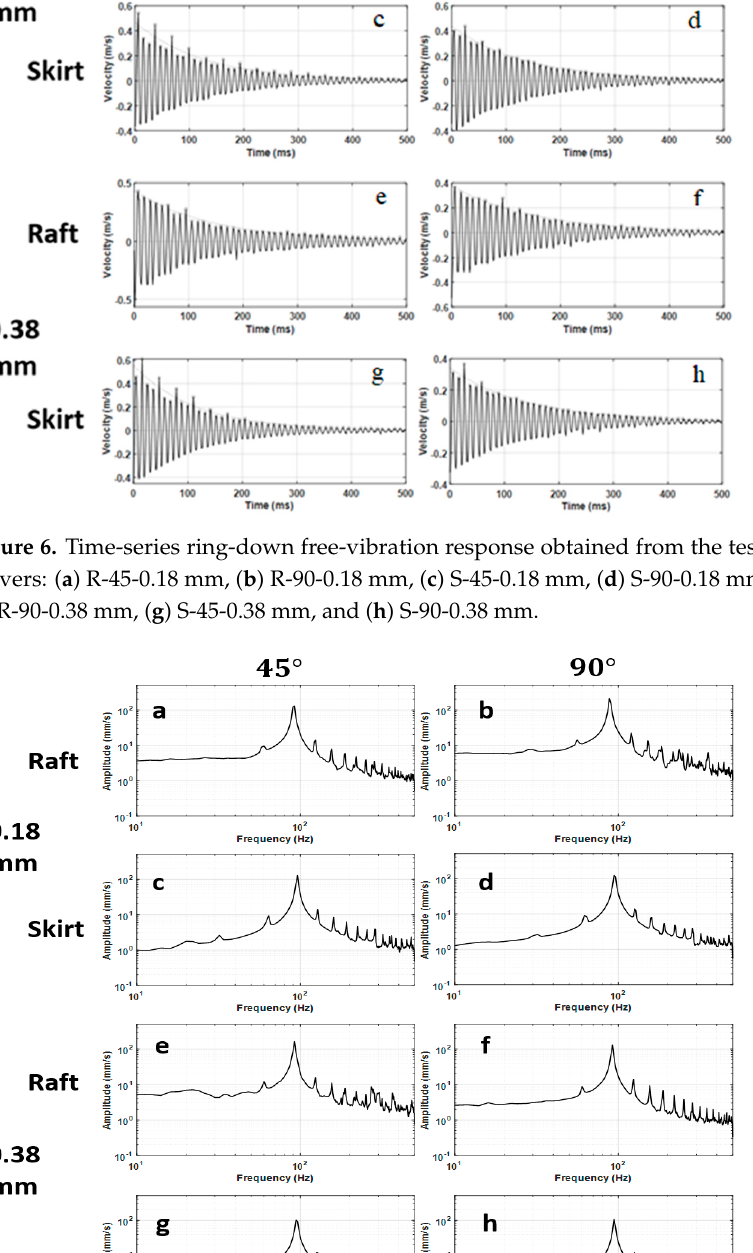
Figure 8. Pair plots of the modal analysis parameters obtained from the free-vibration tests of the 3D printed cantilevers. The variable of interest is the adhesion type (skirt and raft).